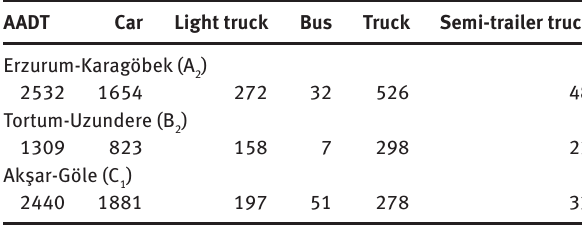
Table 2: Traffic surveying results during test